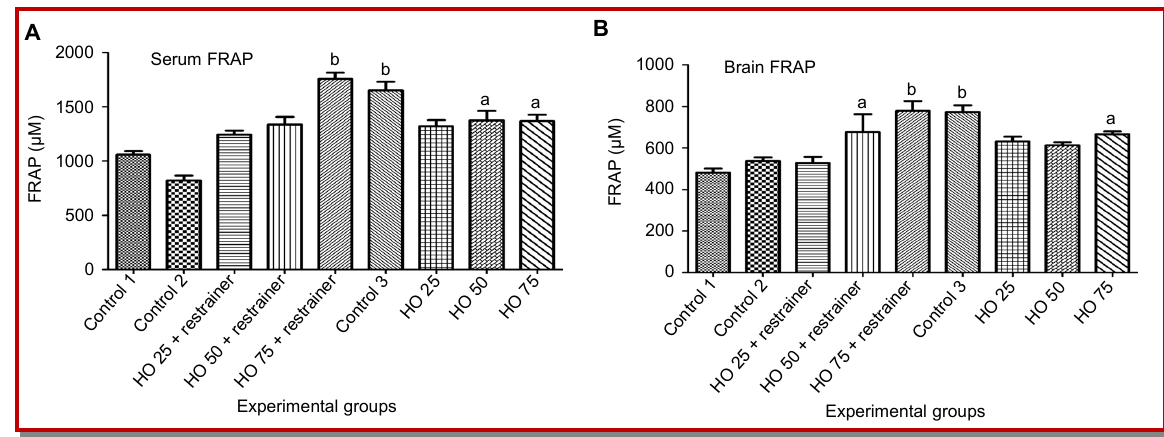
Figure 2: Serum (A) and brain (B) anti-oxidant capacity in different groups; all groups are compared with control Group 1. a Signif- icant difference compared to control 1 group (p<0.05); b significant difference compared to control 1 group (p<0.001); HO: Hyssopus